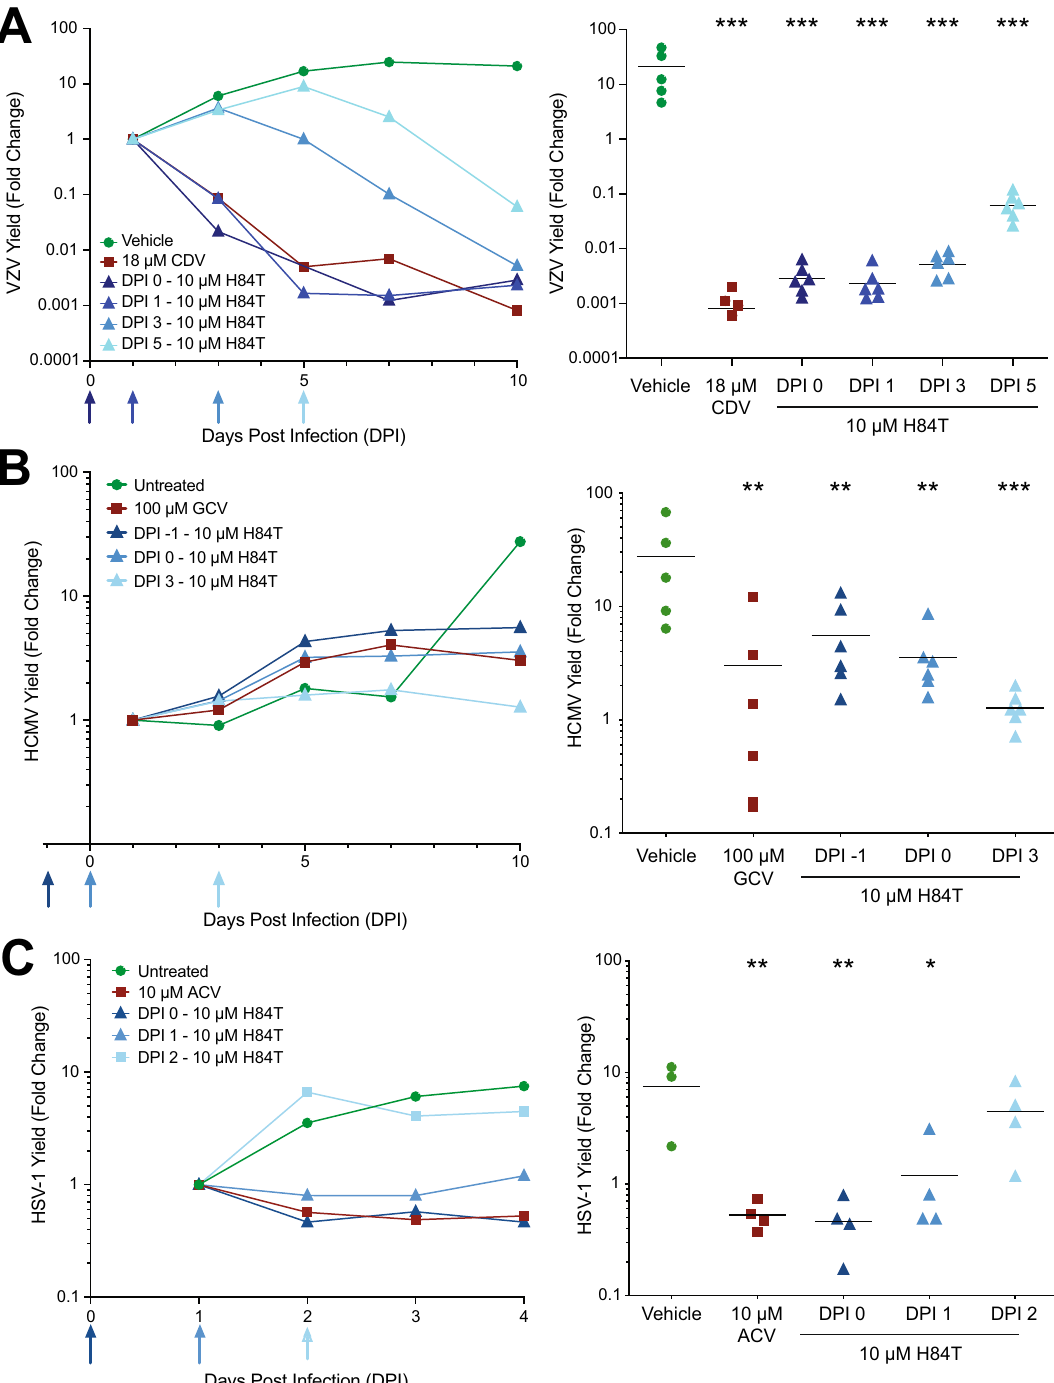
Figure 4. H84T BanLec addition after infection prevented VZV, HCMV, and HSV-1 spread in skin. Adult skin explants were inoculated with VZV ( A ), HCMV ( B ), or HSV-1 ( C ) and then placed on NetWells over medium that contained H84T BanLec (10 µM) added according to the schedule on the x -axis (blue arrows). Control antiviral compounds (cidofovir, CDV, 18 µM; ganciclovir, GCV, 100 µM; acyclovir, ACV, 10 µM) were added at DPI 0. Virus spread was measured by bioluminescence imaging starting on DPI 1. Virus yield on subsequent days was calculated by dividing the average Total Flux (photons/sec/cm 2 /steradian) by the average Total Flux on DPI 1. Viral growth kinetics (left panels, each symbol is the average for the group) were analyzed for statistical significance on the last day (right panels), where each symbol represents one piece of skin and the bar is the mean of the group. The Vehicle and ACV groups in ( C ) are the same as in Fig. 3C, as these experiments were conducted together. Asterisks indicate significance between the treated groups and vehicle (* p < 0.05, ** p < 0.01, *** p < 0.001). p < 0.01, one-way ANOVA, Dunnett’s post hoc test. N = 4–6 biological